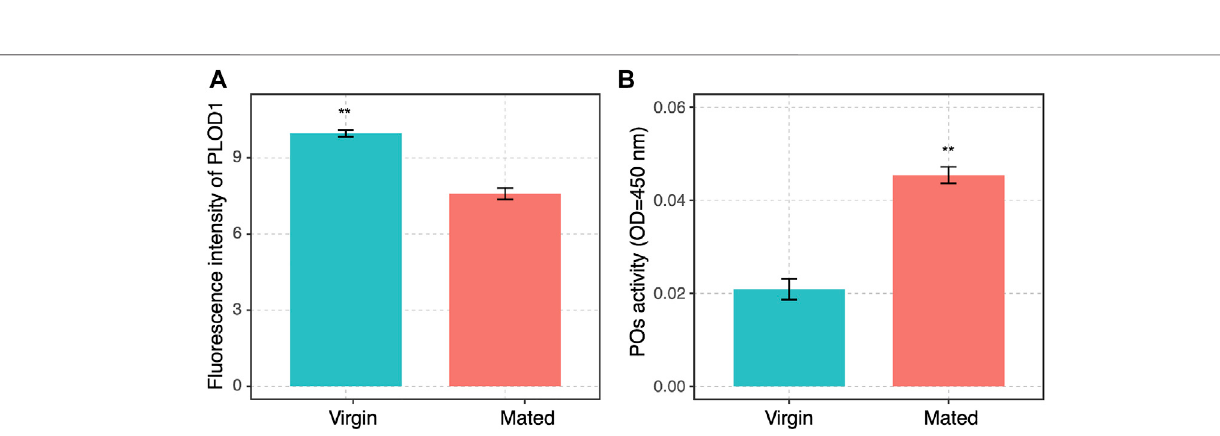
Frontiers in Genetics |